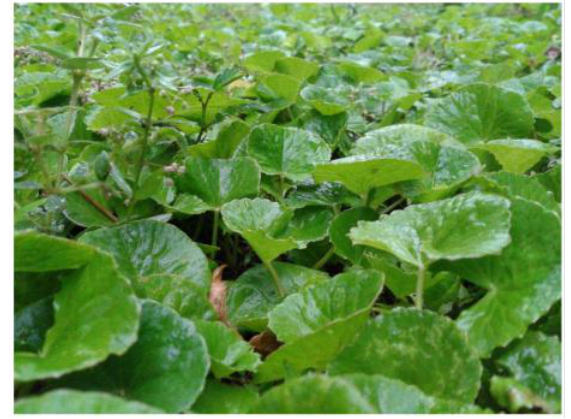
Figure 5. Centella asiatica L.